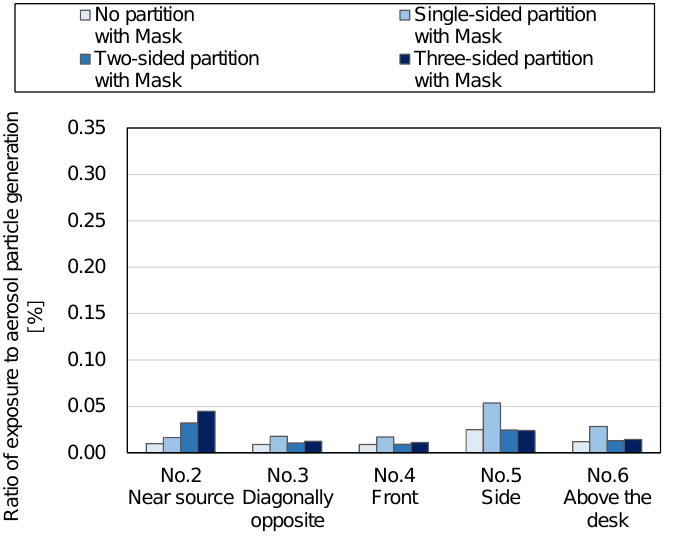
Figure 7. Effect of partition shape (with mask) [21].